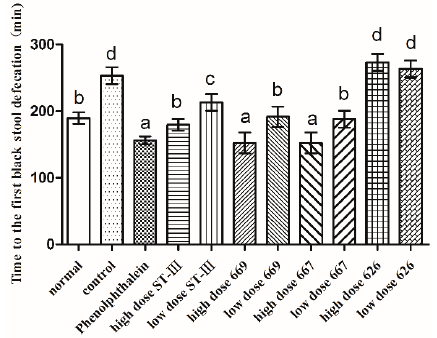
Figure 3. First black stool defecation time of mice after constipation was induced by loperamide in eight BALB/c mice in each group. Phenolphthalein: 10 mg/kg body weight; 626: B. adolescentis CCFM 626; 667: B. adolescentis CCFM 667; 669: B. adolescentis CCFM 669; ST-III: L. plantarum ST-III; High dose: 1 × 10 10 CFU; Low dose: 1 × 10 8 CFU. Mean values with different letters (a–d) over the bars are significantly different ( p < 0.05) according to Duncan’s multiple range test.